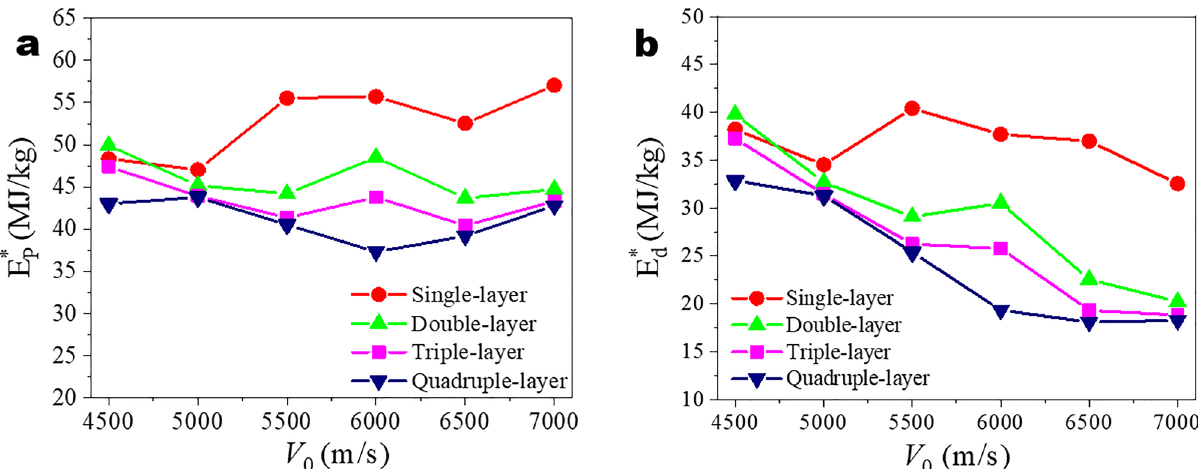
Figure 7. E ∗ P ( a ) and E ∗ d ( b ) of single or multi-layer graphene as a function of initial impact